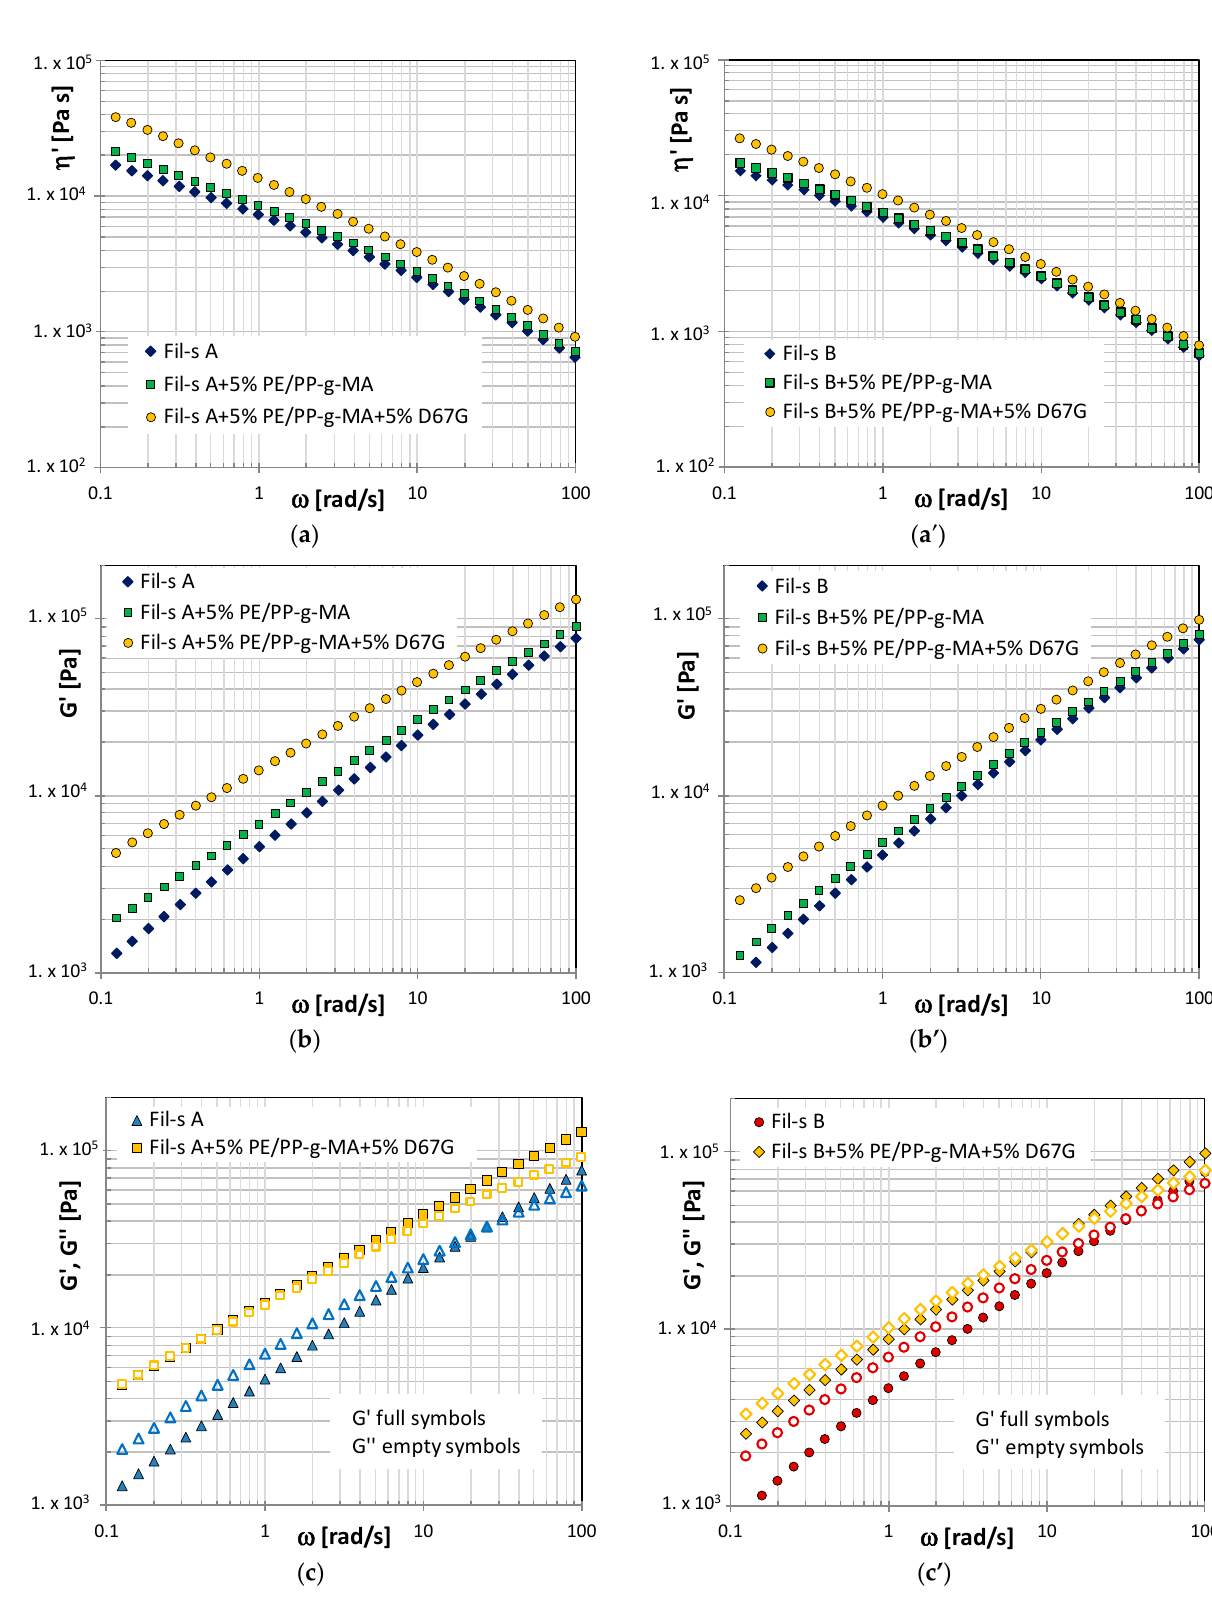
Figure 4. Comparison of the dynamic viscosity η ’ ( a , a’ ), the storage modulus plots G’ ( b , b ’) and the storage and loss moduli, G’, G”, plots ( c , c ’) for Fil-s A and Fil-s B-based systems, respectively.